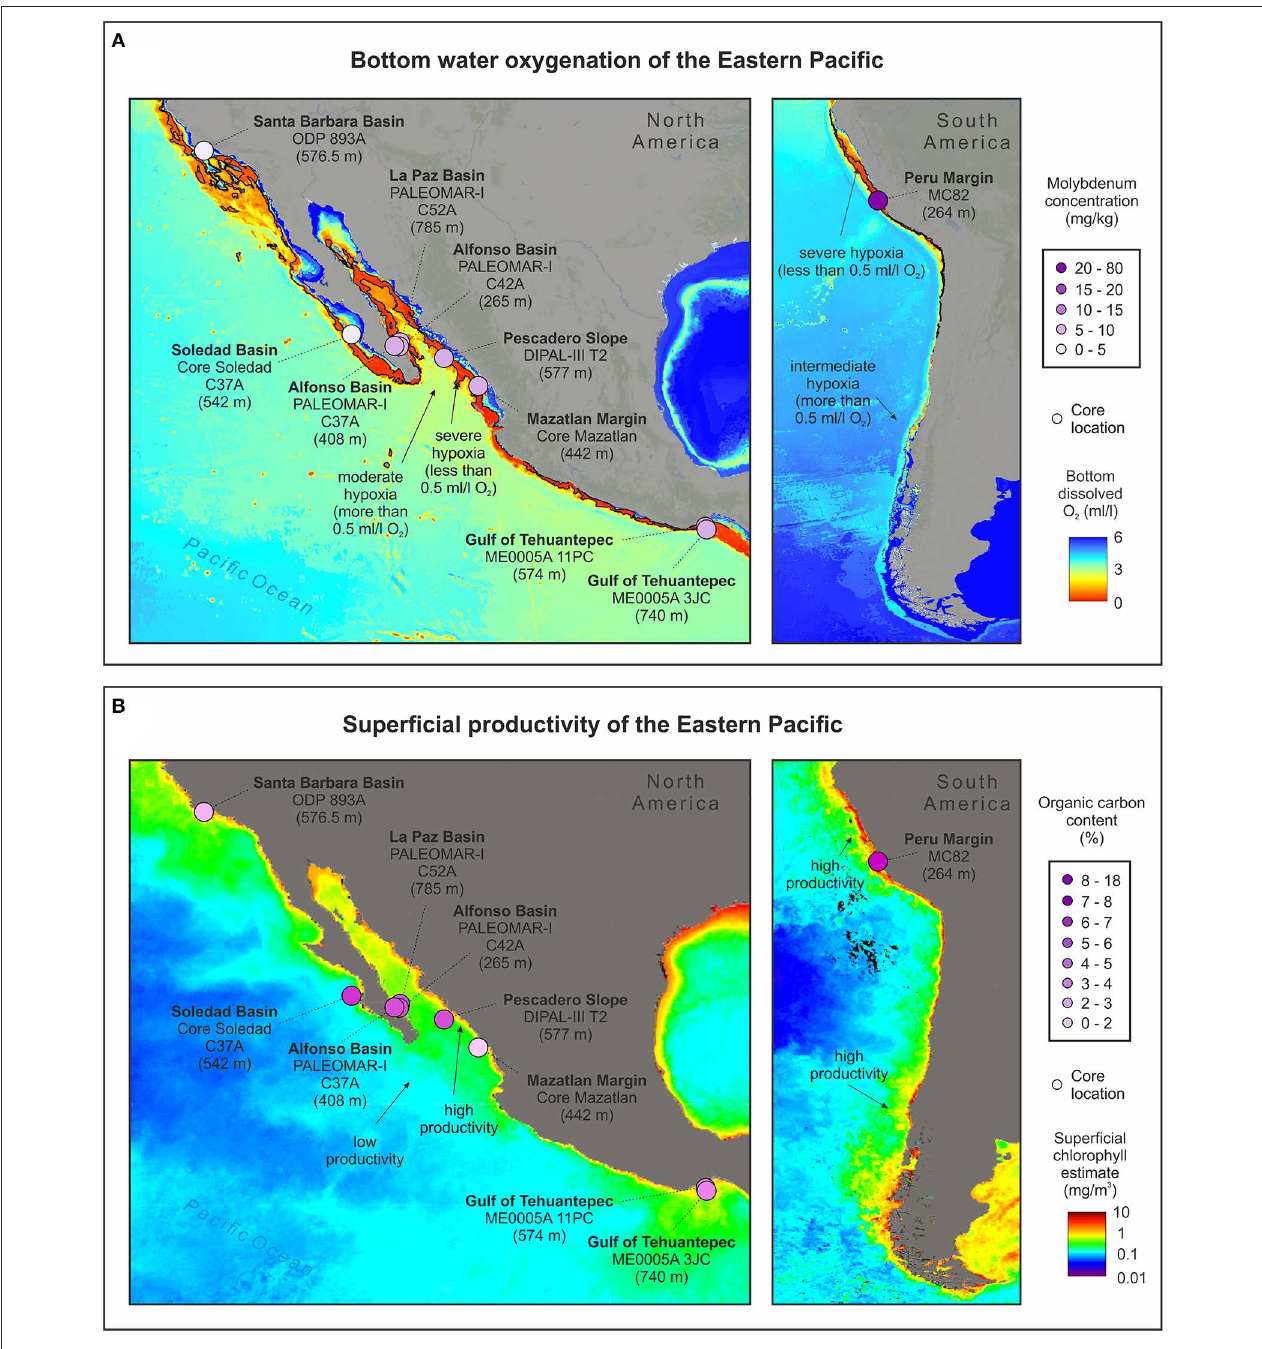
FIGURE 6 | Molybdenum and organic carbon in core tops from various locations across the Gulf of California and adjacent Pacific, (A) bottom dissolved oxygen, and (B) superficial chlorophyll estimate from the studied marine OMZ settings of ETNP (Alfonso Basin and La Paz Basin) (Oxygen based on World Ocean Atlas, 2005; Garcia et al., 2006; superficial chlorophyll estimates by SeaWIFS satellite sensor published by OBPG/NASA).